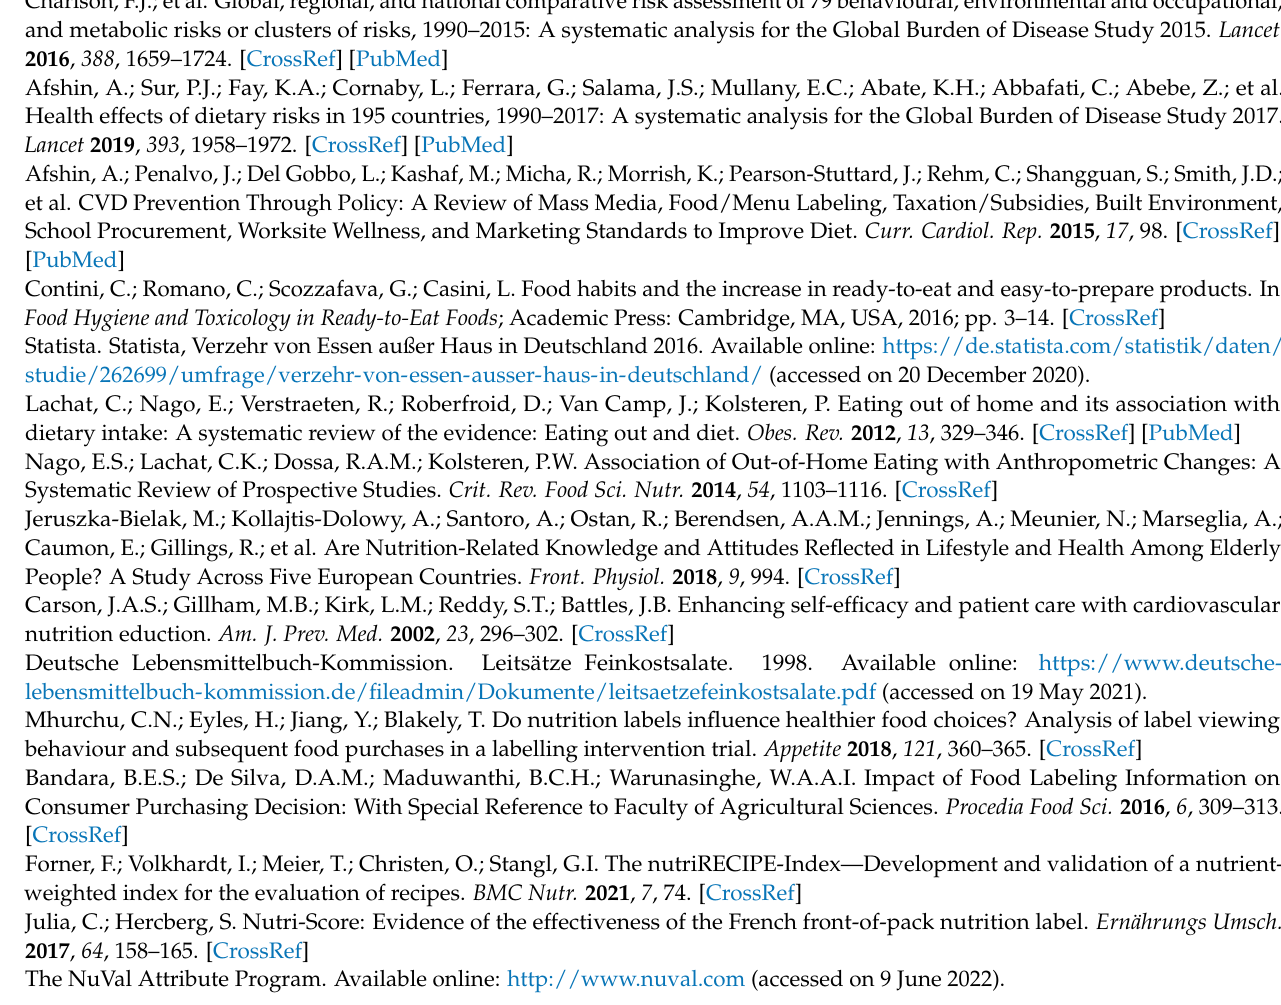
Table S2: Manufacturer’s responses regarding the determination methods; Table S3: Filled template of the Belgian Federal Public Service with calculated Nutri Scores and corresponding nutriRECIPE- Index values with both approaches; Tables S4–S34: Comparison of nutriRECIPE-Index and nutrition content per 100 g among the